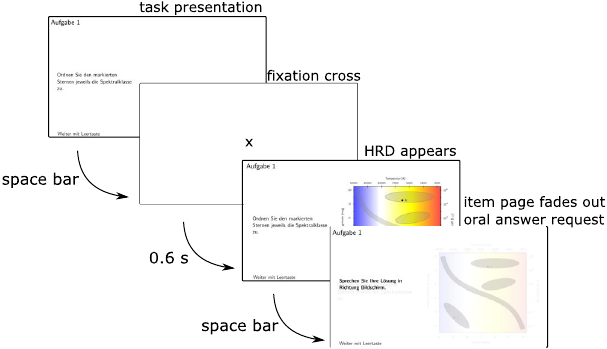
FIG. 3. Procedure of item presentation and answer submission as originally used in the study (English translations can be found in the Supplemental Material [51]). The item text appears on the left half of the screen. The corresponding item diagram is displayed under the user ’ s control. In between, the user looks at a fixation cross. When the participant has solved the item in his or her head, he or she presses the space bar and gets to the input page. Here, the background fades out, and the prompt to speak the answer